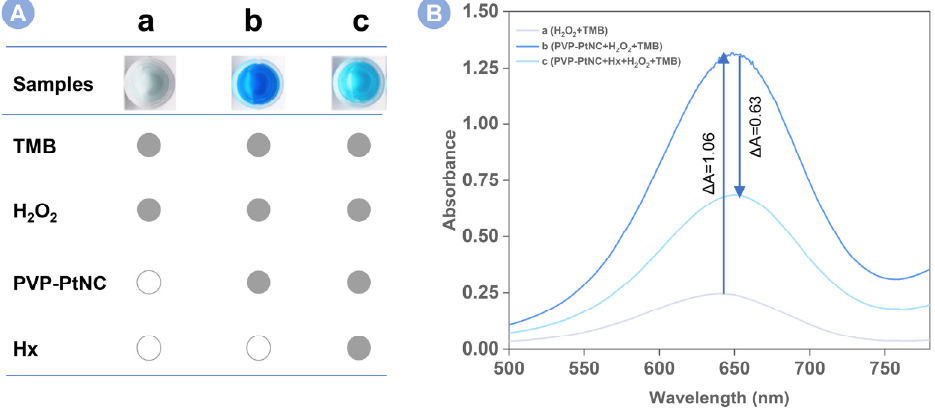
Figure 2. ( A ) Photographed images and ( B ) UV–vis absorption spectra of (a) TMB + H 2 O 2 , (b) PVP- PtNC + TMB + H 2 O 2 , and (c) PVP-PtNC + Hx + TMB + H 2 O 2